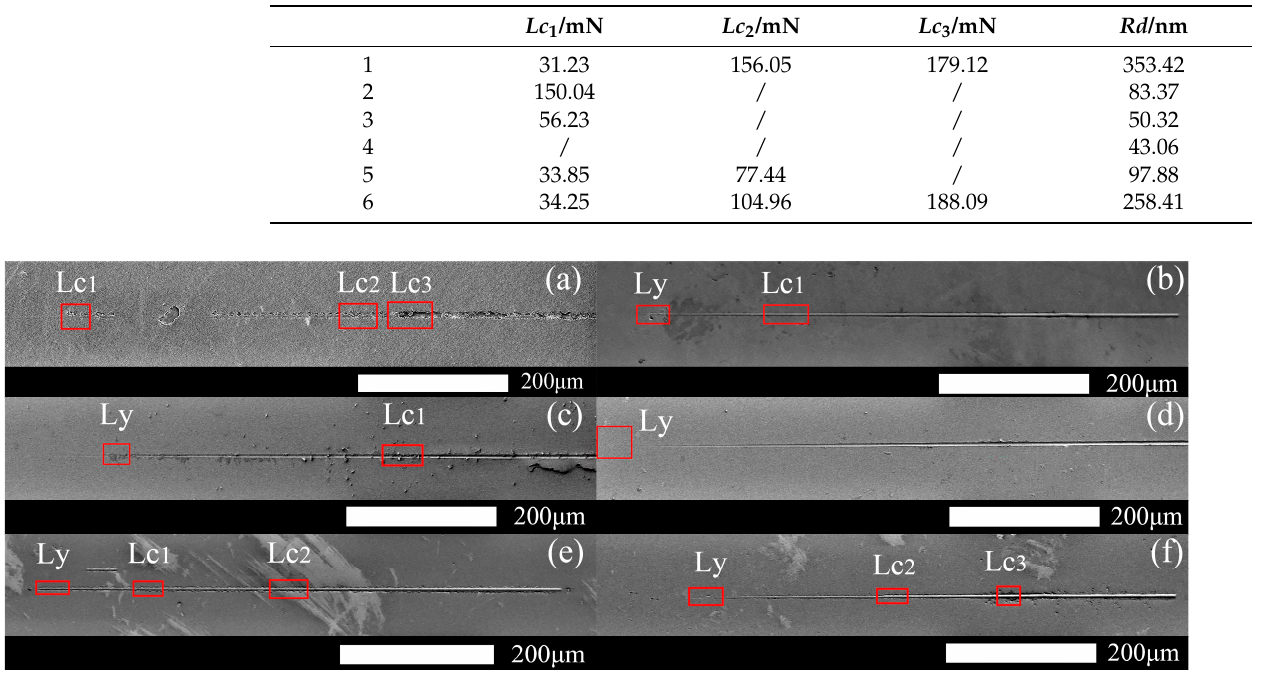
Figure 5. Optical transmittance of the Si-B-C-N/DLC gradient films; t he visible wavelength range is within the two dashed lines.